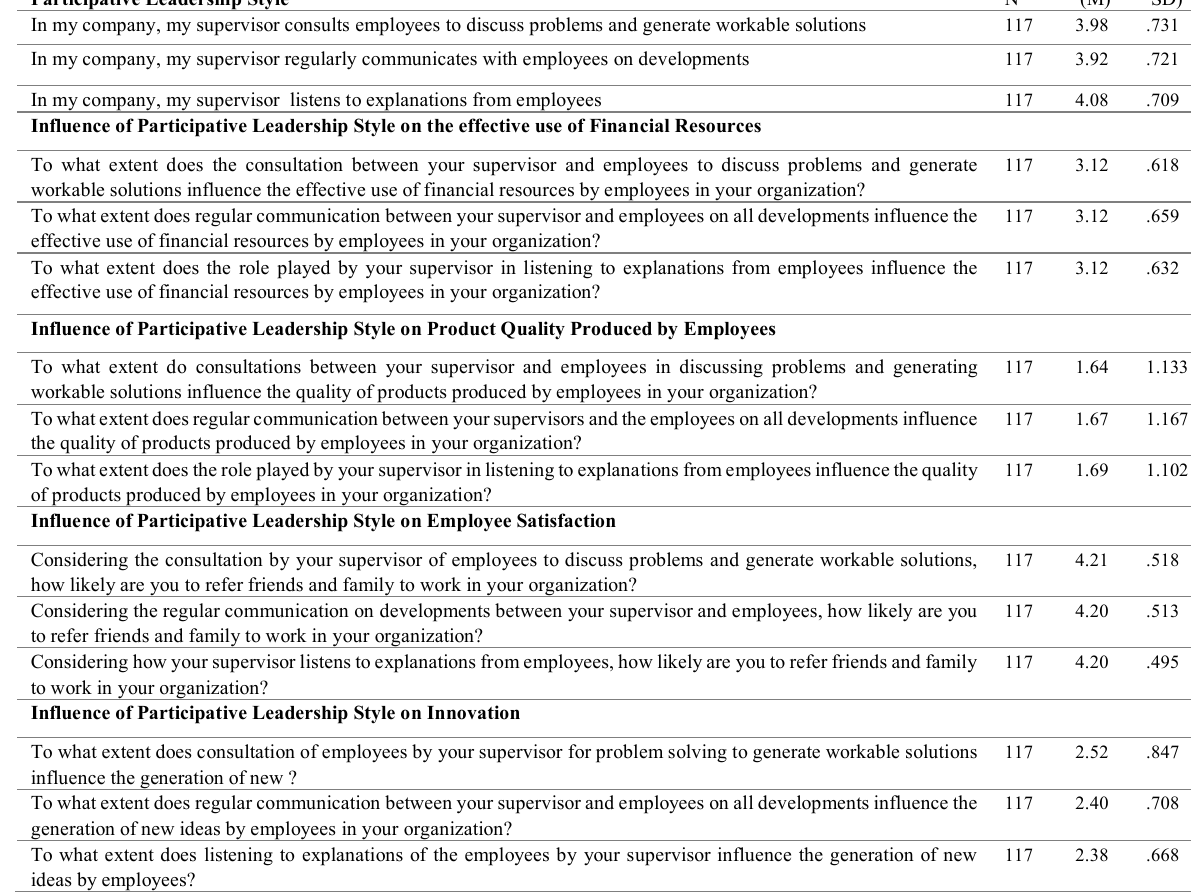
Table 6: Mean and standard deviation of participative leadership